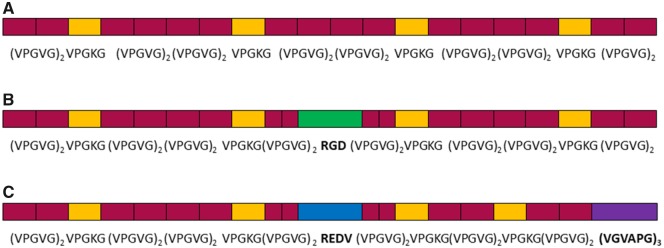
Graphical scheme of the ELR compositions: (A) VKVx24; (B) HRGD6; (C) REDV